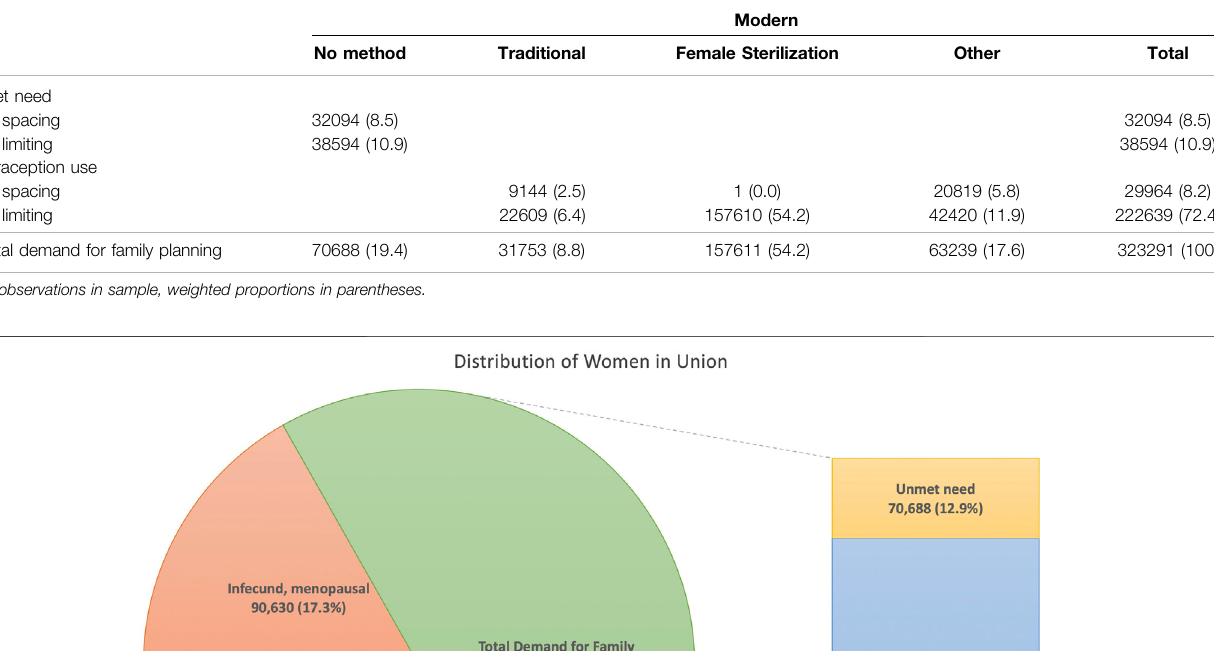
TABLE 1 | Total demand for family planning for married women aged 15 – 49: unmet + met contraception need by type of method,